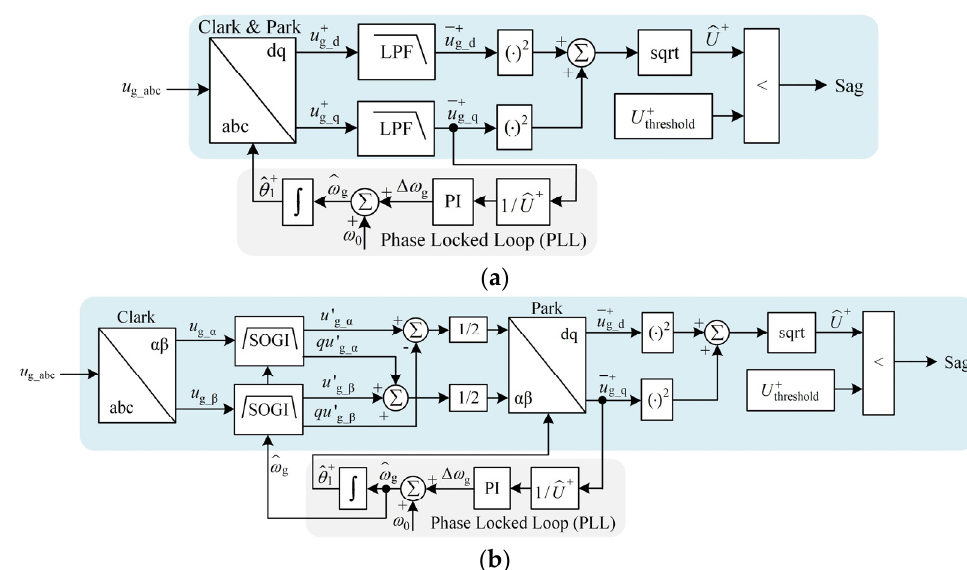
Figure 3. Traditional voltage sag detection methods based on SRF. ( a ) SRF-LPF; ( b ) DSOGI-SRF.